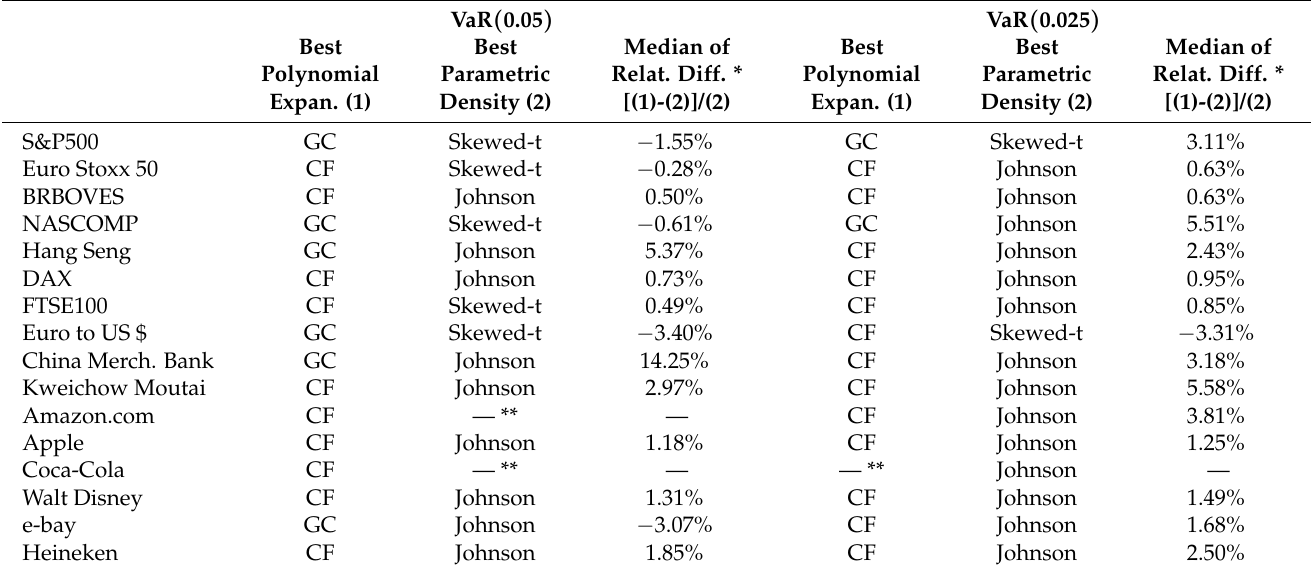
Table 5. Comparison of Distributions with Loss Functions: